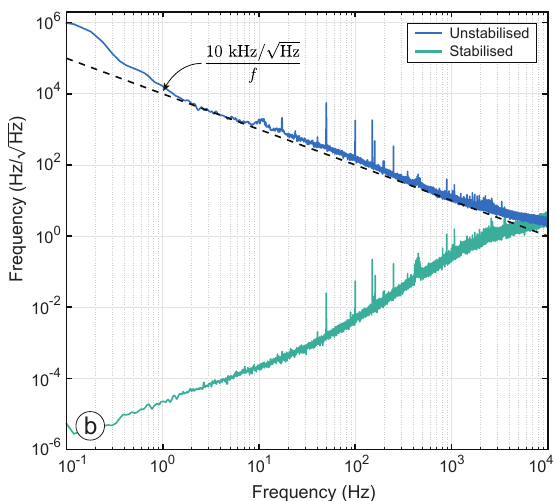
Figure 11. Free-running (unstabilized) and stabilized laser frequency measured in-loop. The controller stabilizes laser frequency noise at a bandwidth of up to approximately 10 kHz as expected.